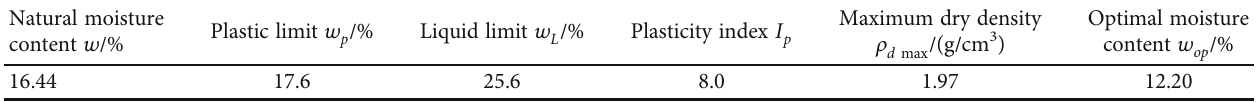
Table 1: Physical properties of soil samples.